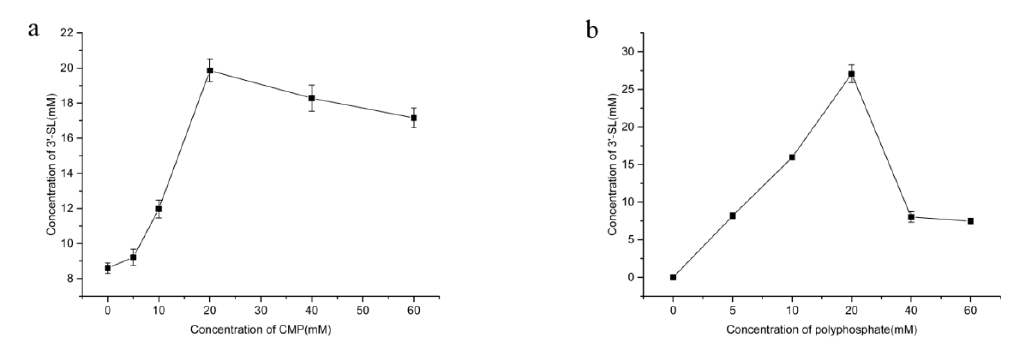
Figure 7. E ff ect of CMP and polyphosphate concentration on the production of 3 (cid:48) -SL. ( a ) E ff ect of CMP concentration on the production of 3 (cid:48) -SL; ( b ) E ff ect of polyphosphate concentration on the production of 3 (cid:48)